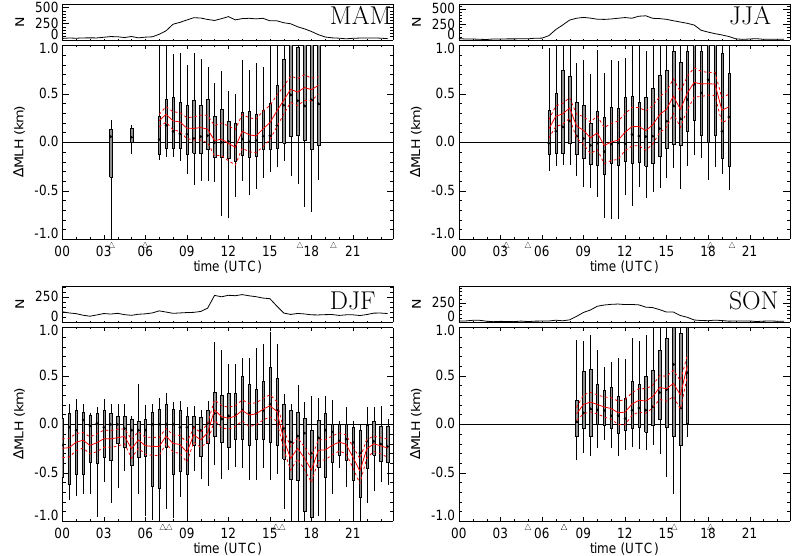
Figure 7. Difference 1 MLH=MLH aero − MLH wind for the four seasons. Whiskers and boxes indicate 10, 25, 75 and 90% percentiles and dots indicate the median. Red lines indicate average (solid) and the error estimate based on the sensitivity studies in Sects. 2.1.4 and Sect. 2.2.2 (dashed). Triangles at the abscissa mark range of sunrise and sunset during the respective season.